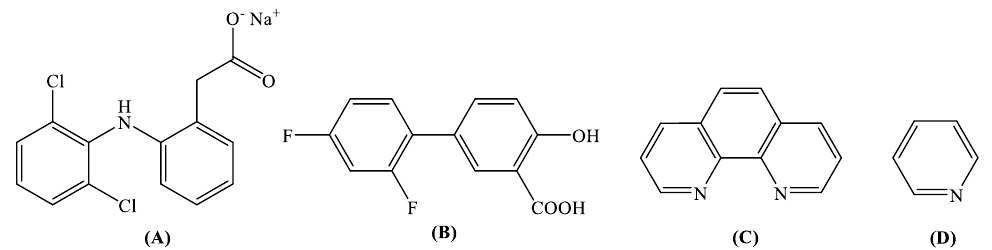
Figure 1. Syntax formula of ( A ) sodium diclofenac (Nadicl), ( B ) diflunisal (H 2 difl), ( C ) 1,10-phenanthroline (phen), and ( D ) pyridine (py).